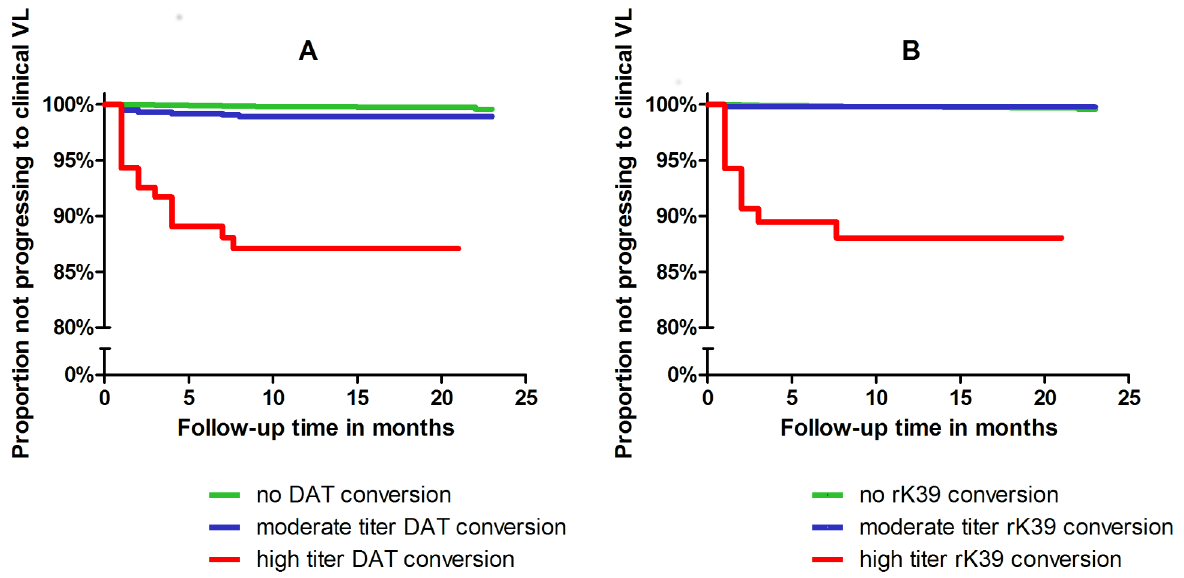
Figure 2. Risk of progression to clinically symptomatic VL according to the class of (A) DAT or (B) rK39 titer at time of seroconversion.